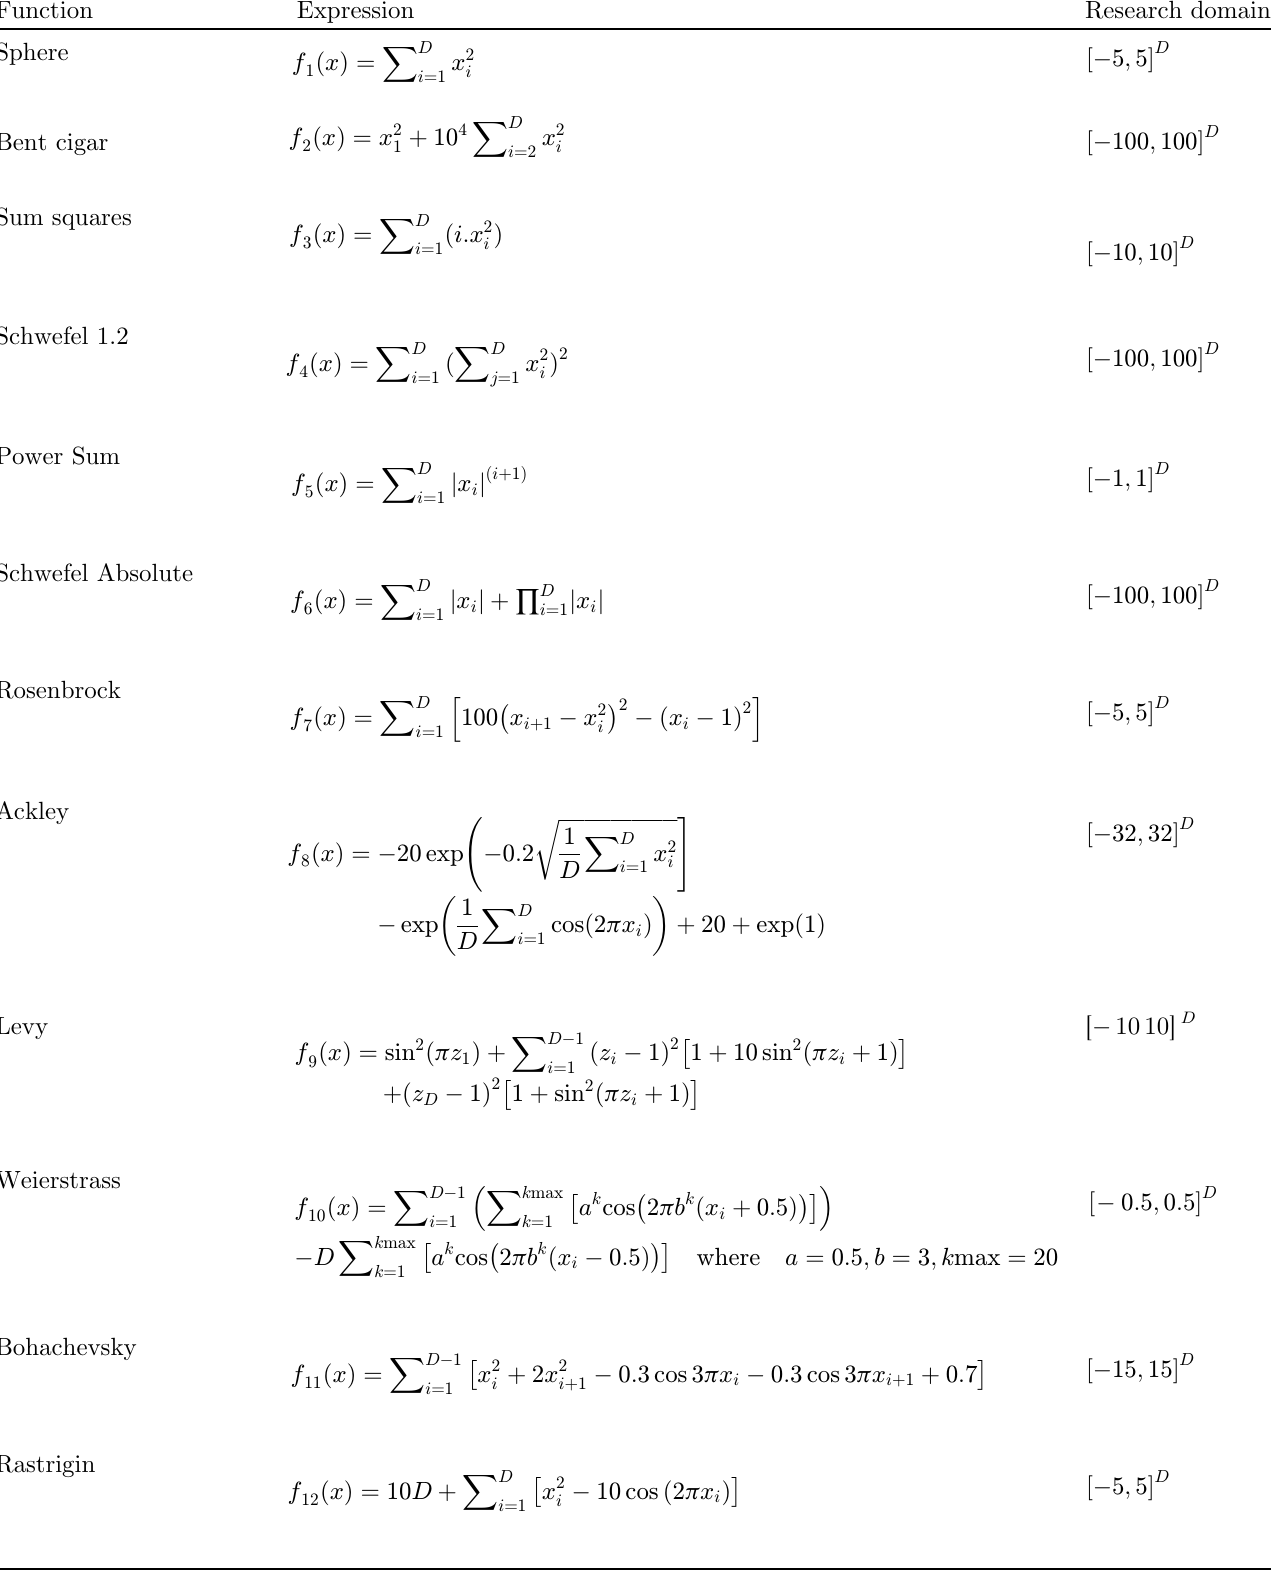
Table 1. Test functions for numerical